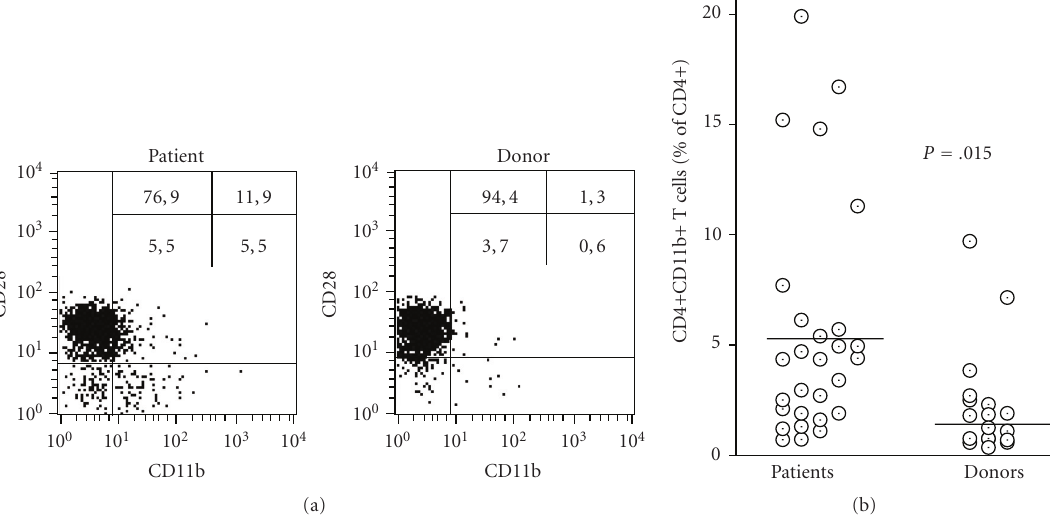
Figure 1: Expression of CD11b and CD28 on CD4+ T cells of patients with implant-associated osteomyelitis and of healthy donors: (a) by cytofluorometry expression of CD11b and CD28 were determined. The gate was set for CD4+ cells. With regard to CD11b and CD28 expressions, four populations were detected: CD28+CD11b-, CD28+CD11b+, CD28-CD11b-, and CD28-CD11b+ (an example for a patient and a donor is shown in (a) (The numbers give the percentage of CD4+ found in the respective quadrant.) (b) The percentage of CD4+CD11b+ in the patients ( n = 28) and the donors ( n = 18) is shown. The horizontal bar indicates the median value. The mean values for the patients (mean ± SD 5.6 ± 5.3%) di ff ered significantly from that obtained for the donors (2.2 ± 2.4%) as calculated by ANOVA ( P = . 015)